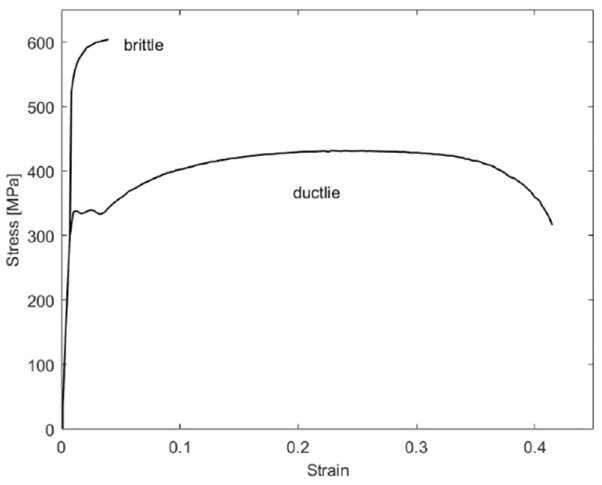
Figure 3. Brittle vs. ductile behavior in materials.